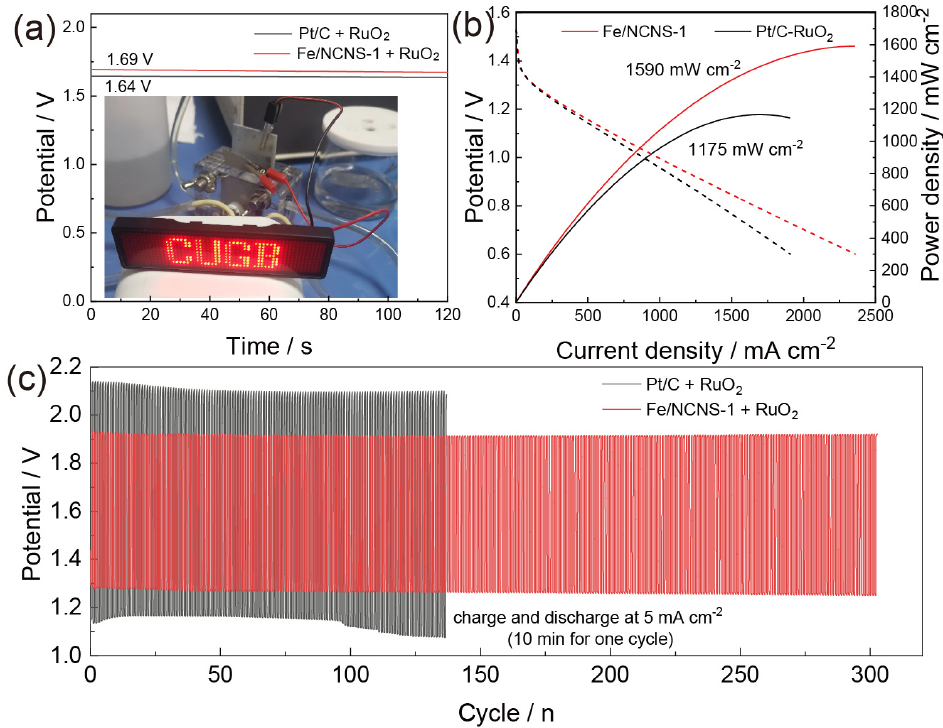
Figure 5. ( a ) Open circuit measurements for the Zn-air battery with Fe/NCNS-1 + RuO 2 and Pt/C + RuO 2 as air catalysts; ( b ) discharge polarization curves and the corresponding power density of the Zn–air batteries, ( c ) cycling stability of Fe/NCNS-1 + RuO 2 and Pt/C + RuO 2 at discharge/charge current densities of 5.0 mA cm − 2 .